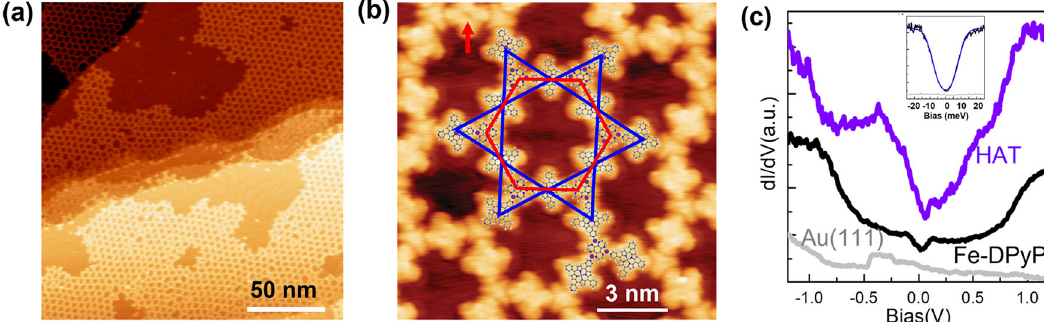
ð Fe (cid:2) DPyP Þ 3 coordination network 2